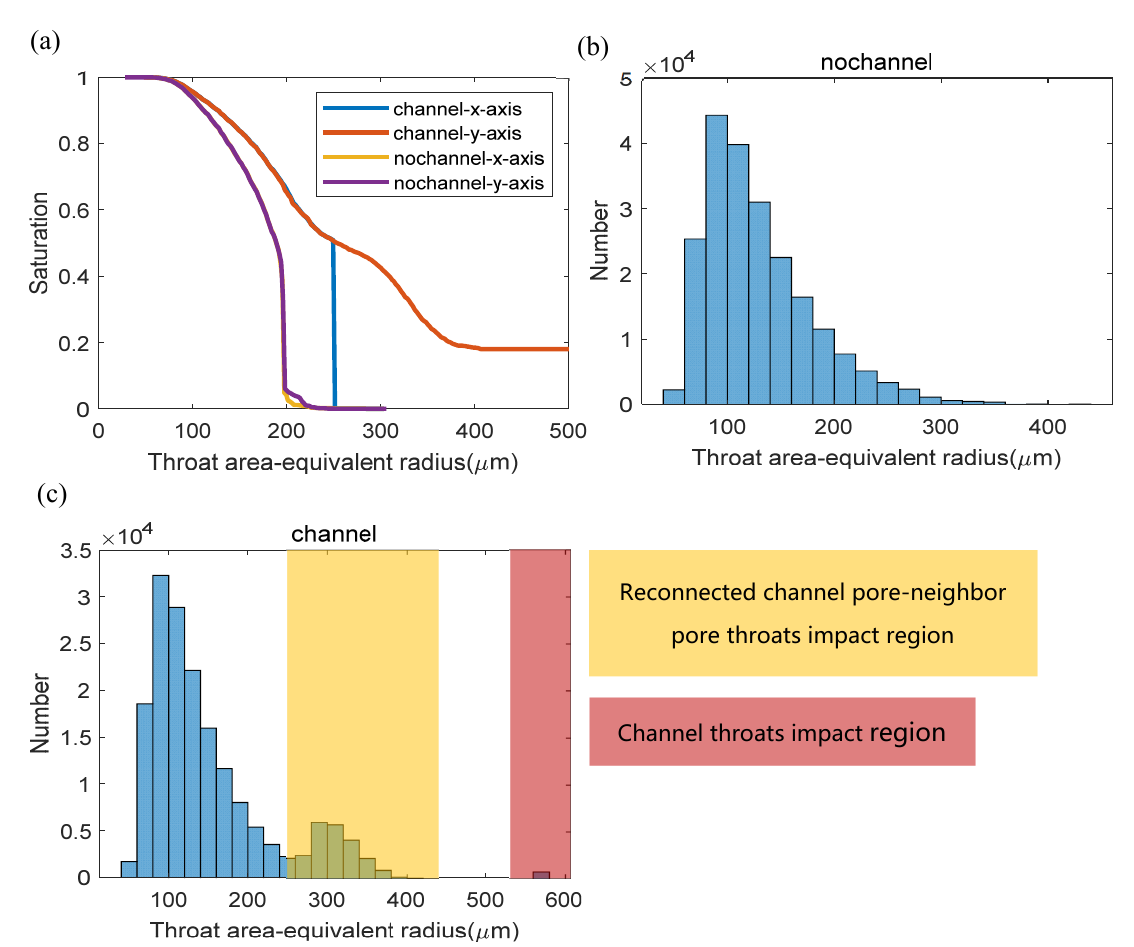
Figure 11. ( a ) Throat area-equivalent radius and saturation relationship curves, and throat area-equivalent radius distribu- tions of pore network without ( b ) and with ( c )